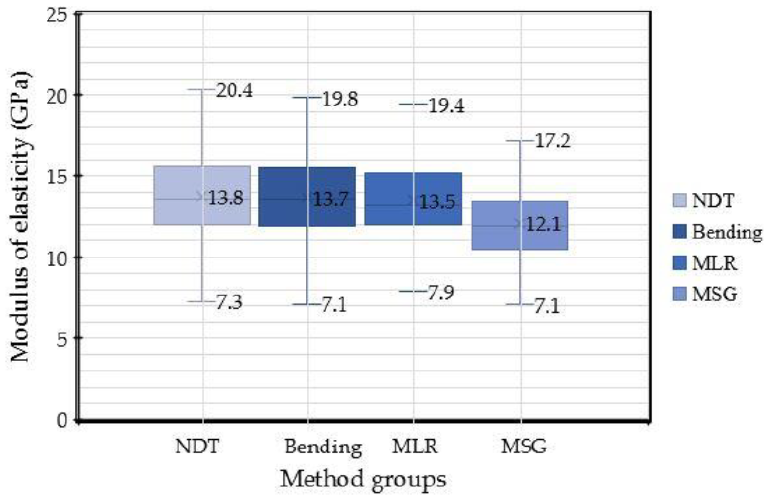
Figure 13. Comparison between the measurement methods of predicting modulus of elasticity .